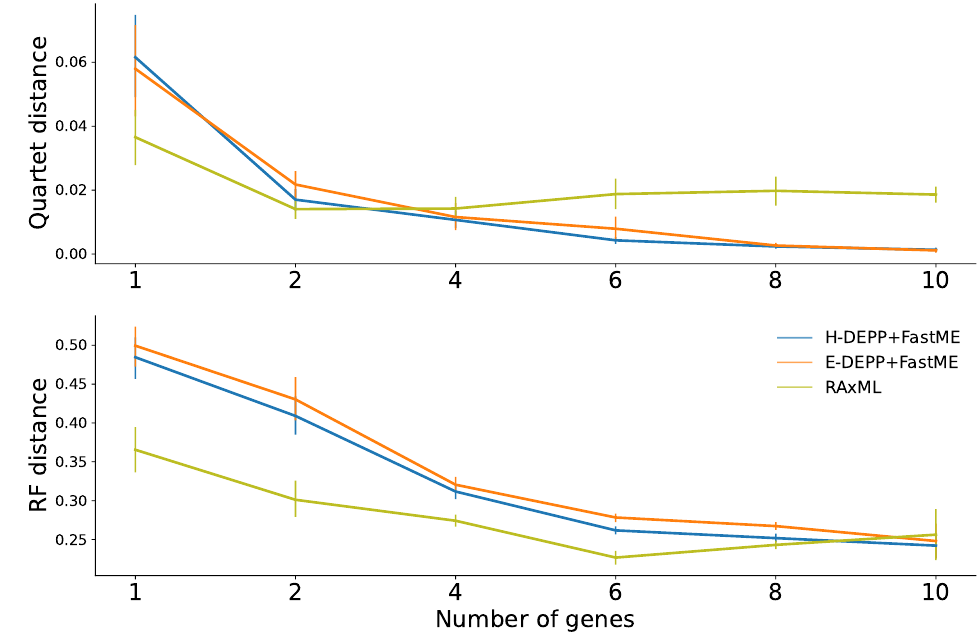
Figure A2. Errors of updated trees measured by ( top ) quartet distances; ( bottom ) RF distances; Results are from WoL marker genes